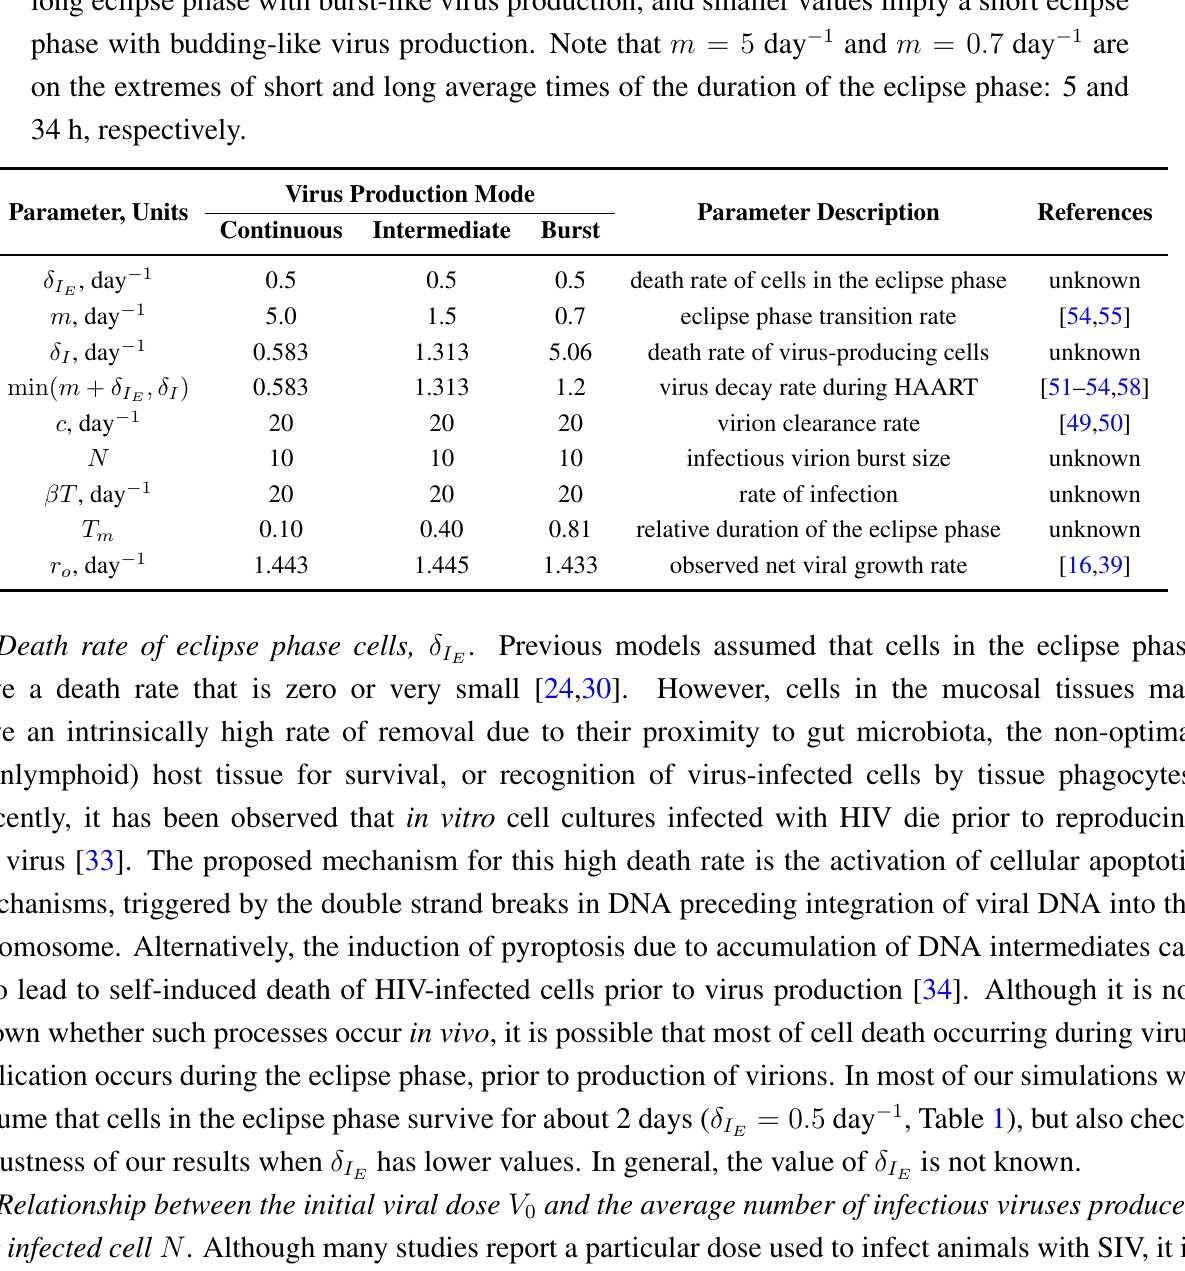
Virus Production Mode Parameter, Units Continuous Intermediate Burst